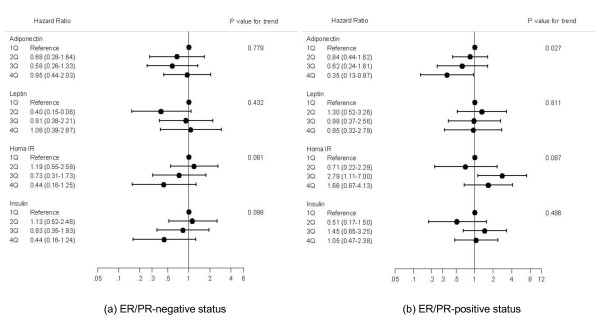
Adjusted hazard ratio for breast cancer recurrence according to estrogen receptor/progesterone receptor status. Cox-proportional regression was used for the estimation of hazard ratios with its 95% confidence intervals and P-value for trend. Hazard ratios were adjusted for age (<40, 40 to 49, 50 to 59, or ≥60 years), alcohol consumption (none, 0.1 to 6.9, or ≥7.0 g/day), BMI (<23.0, 23.0 to 24.9, or ≥25 kg/m2), regional lymph node metastasis (negative or positive), tumor size (<2 cm or ≥2 cm), and chemotherapy (yes or no).